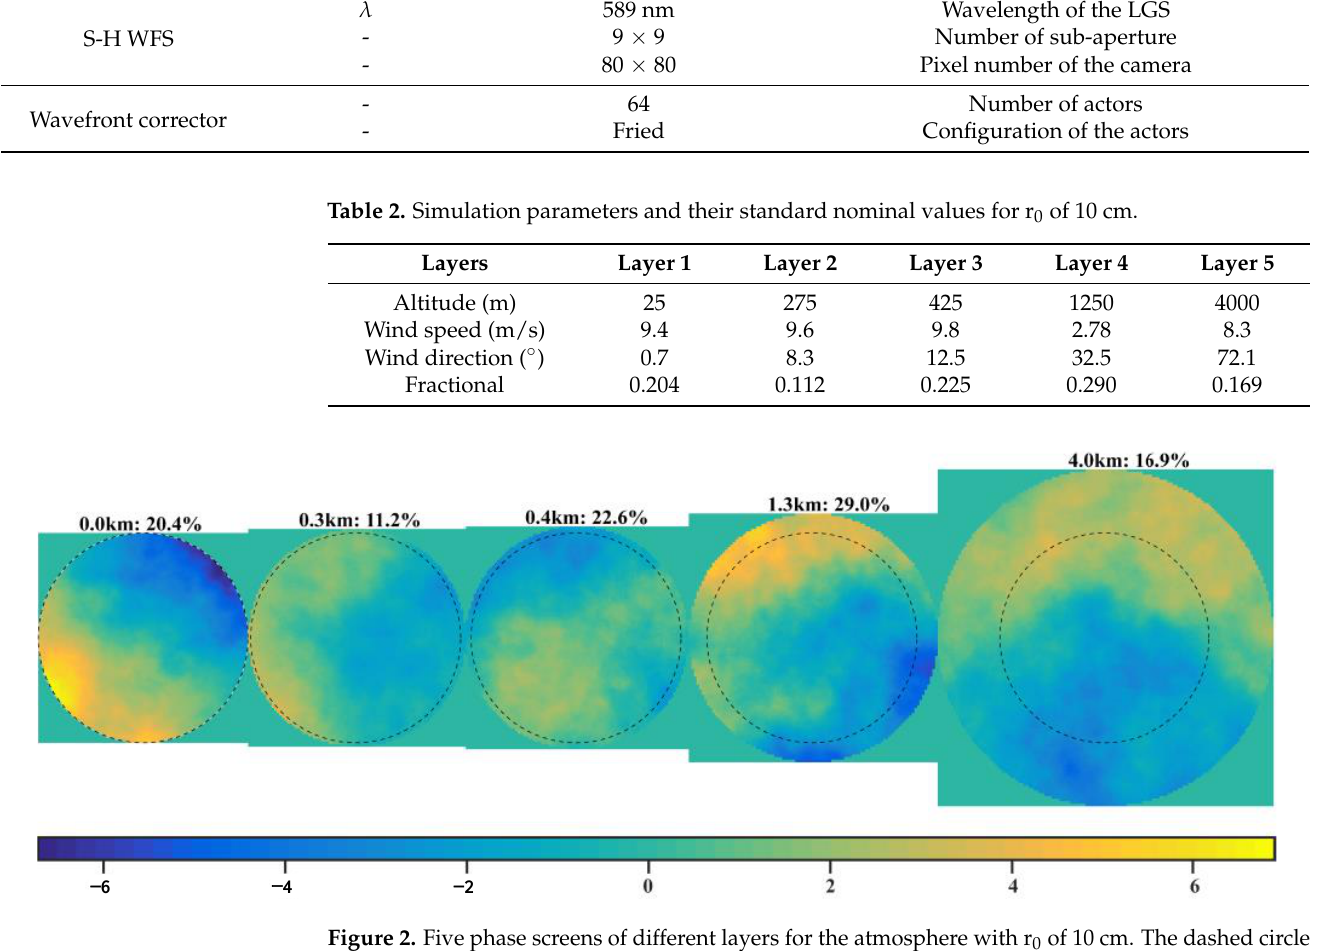
Table 1. Parameters of the telescope and the AO system.